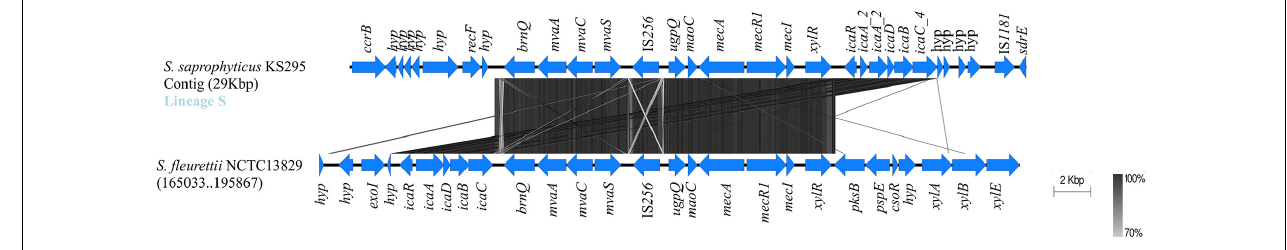
FIGURE 5 | Evidence for the probable acquisition of ica gene cluster and SCC mec -associated genes in Staphylococcus saprophyticus . Structure of ica operon located downstream of SCC mec elements that were found in one S. saprophyticus isolate in lineage S. Blocks of identical color represent nucleotide sequence homology between regions found in the two species. The darker-shade region depicts the highest homology, and genes are represented by arrows facing the direction of transcription. The ica genes and the SCC mec -associated genes and the vicinity found in S. saprophyticus KS295 were compared with the closed